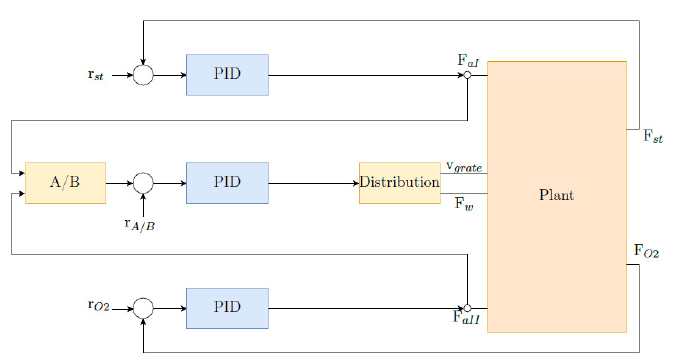
Figure 1. Schematic of a PID controller for waste incineration (adapted from